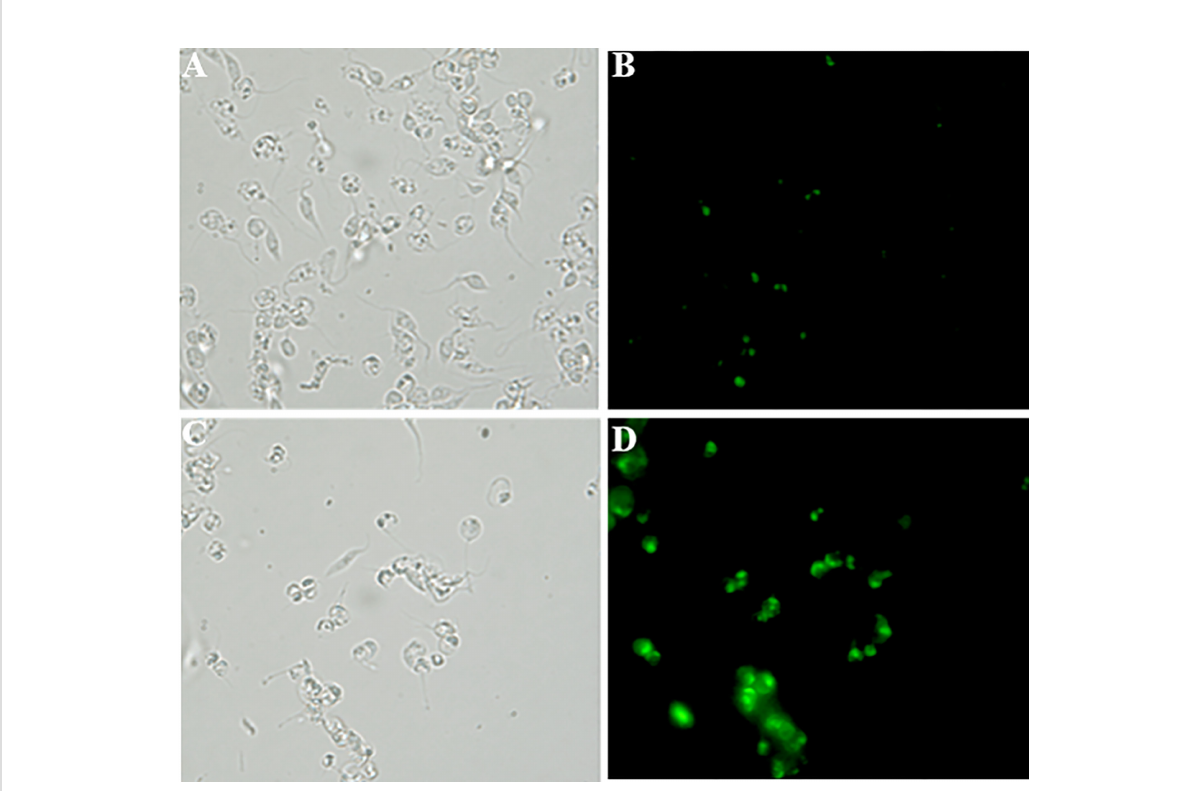
FIGURE 6 Detection of cellular reactive oxygen species (ROS) in T. cruzi epimastigote forms (Y strain) using the H 2 DCFDA probe accessed by fl uorescence microscopy (B, D) . (A, B) - Control and (C, D) - 10µM DETC-treated. (A, C) - phase contrast images. Note intense and compartmented staining in DETC-treated parasites. Magni fi cation - 400X.